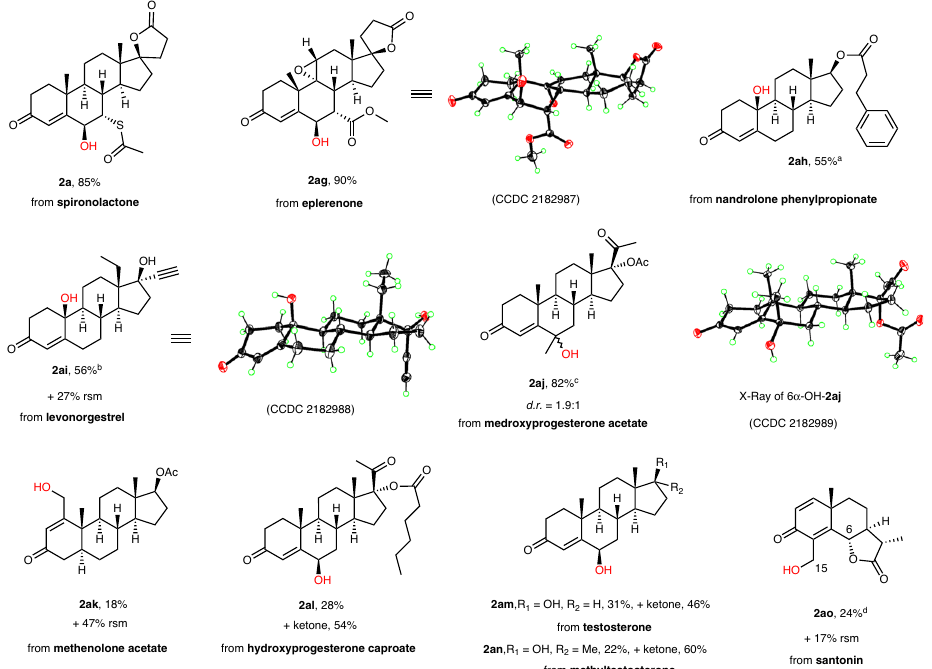
added and stirred for 4h unless otherwise noted; Isolated yields are reported. a 4